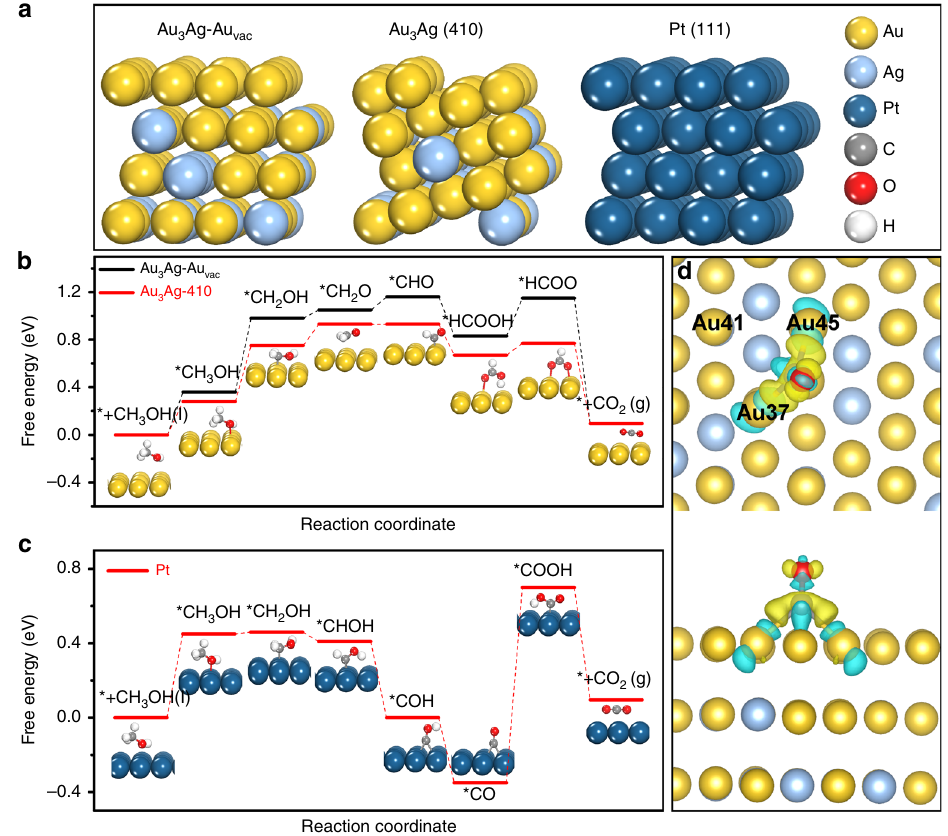
Fig. 5 Simulated methanol oxidation mechanisms on the catalyst surfaces. a Stable con fi guration of Au 3 Ag – Au vac , Au 3 Ag (410), and Pt (111) surface. b , c Calculated free energy change of methanol oxidation intermediates on the Au 3 Ag – Au vac , Au 3 Ag (410), and Pt (111) surfaces, insets are the corresponding con fi gurations of adsorbed intermediates. d Differential charge density of adsorbed CO on Au 3 Ag – Au vac , where the yellow and cyan contour with an iso-surface value of 0.0001 e/bohr 3 indicate reduced and enhanced charge density, respectively. The H, O, C, Au, Ag, and Pt atoms are in white, red, grey, yellow, light blue, and dark blue colors,